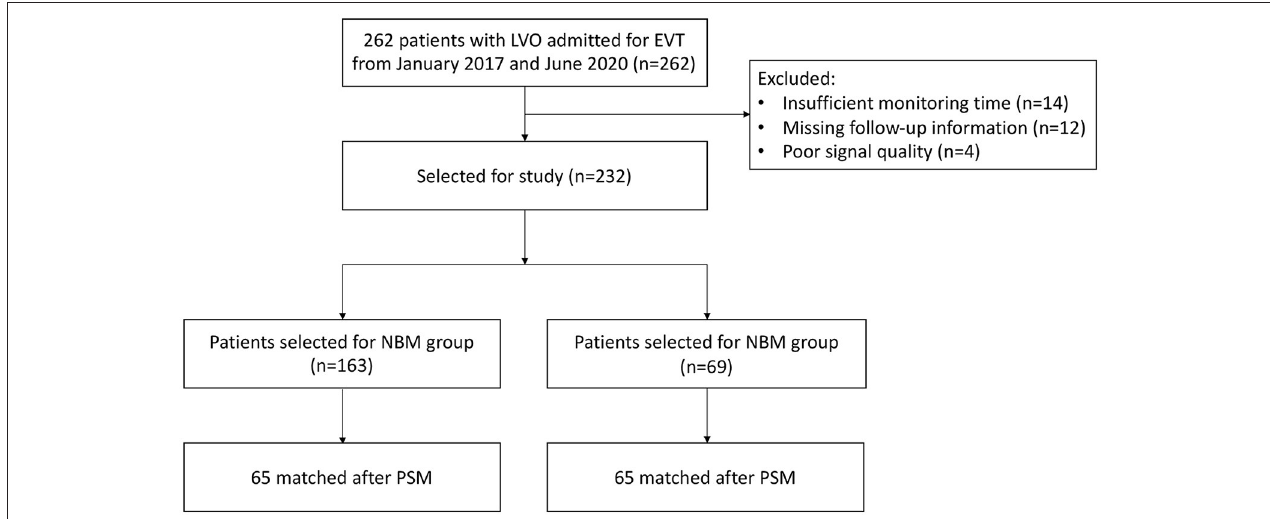
FIGURE 2 | Study flowchart. LVO, large-vessel occlusion; NBM, non-TCD-guided BP management; TBM, TCD-guided BP management; PSM, propensity score methods.